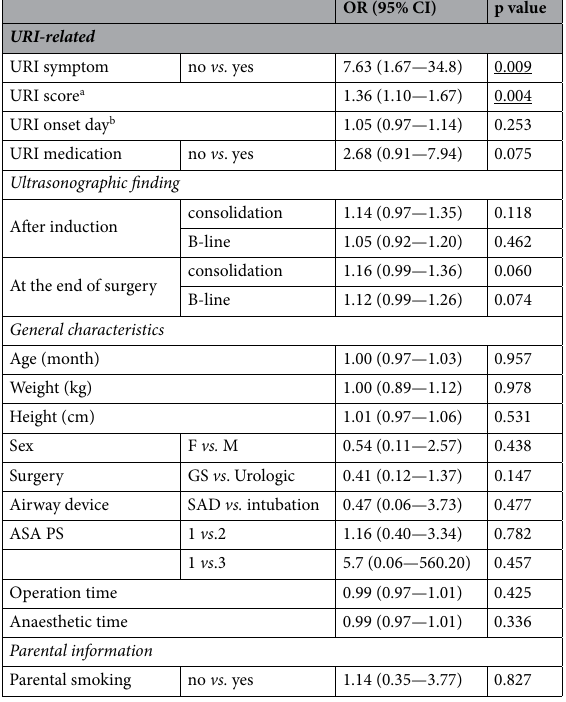
infection, F; female, M; male, GS; general surgery, SAD; supraglottic airway device, ASA PS; American society of anaesthesiologists physical status. a Range of data: from 0 to 24. b Range of data: from 0 to